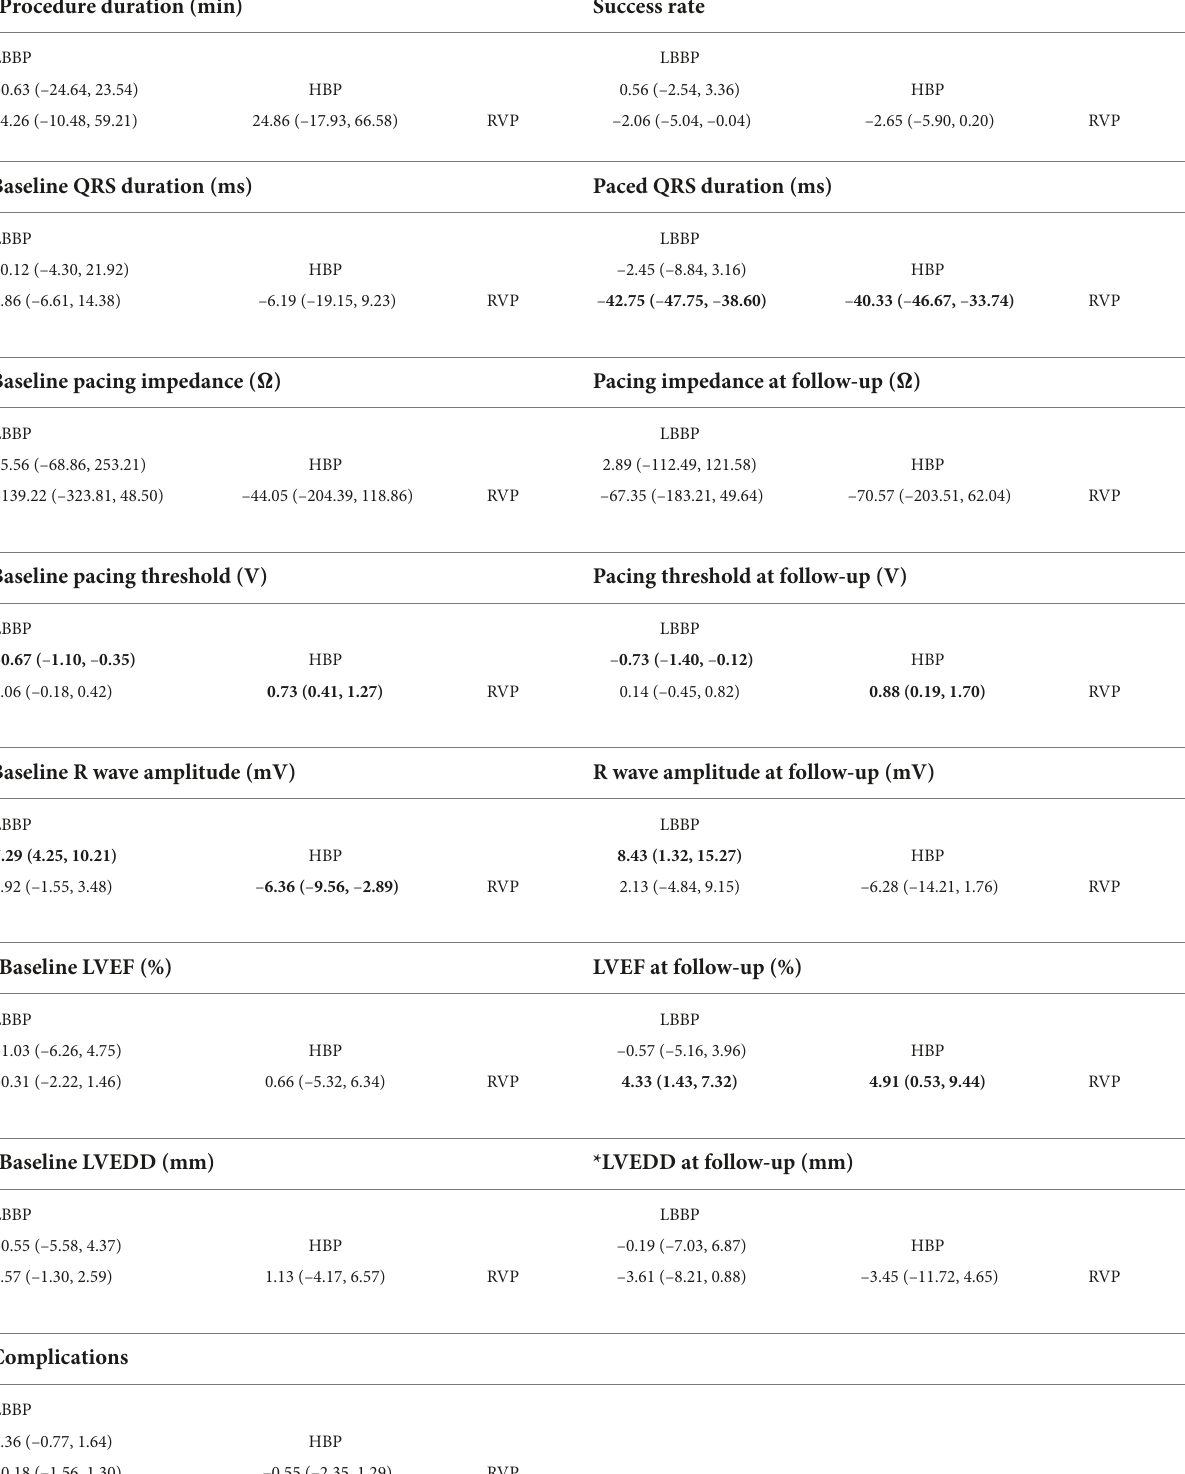
TABLE 3 League tables of network